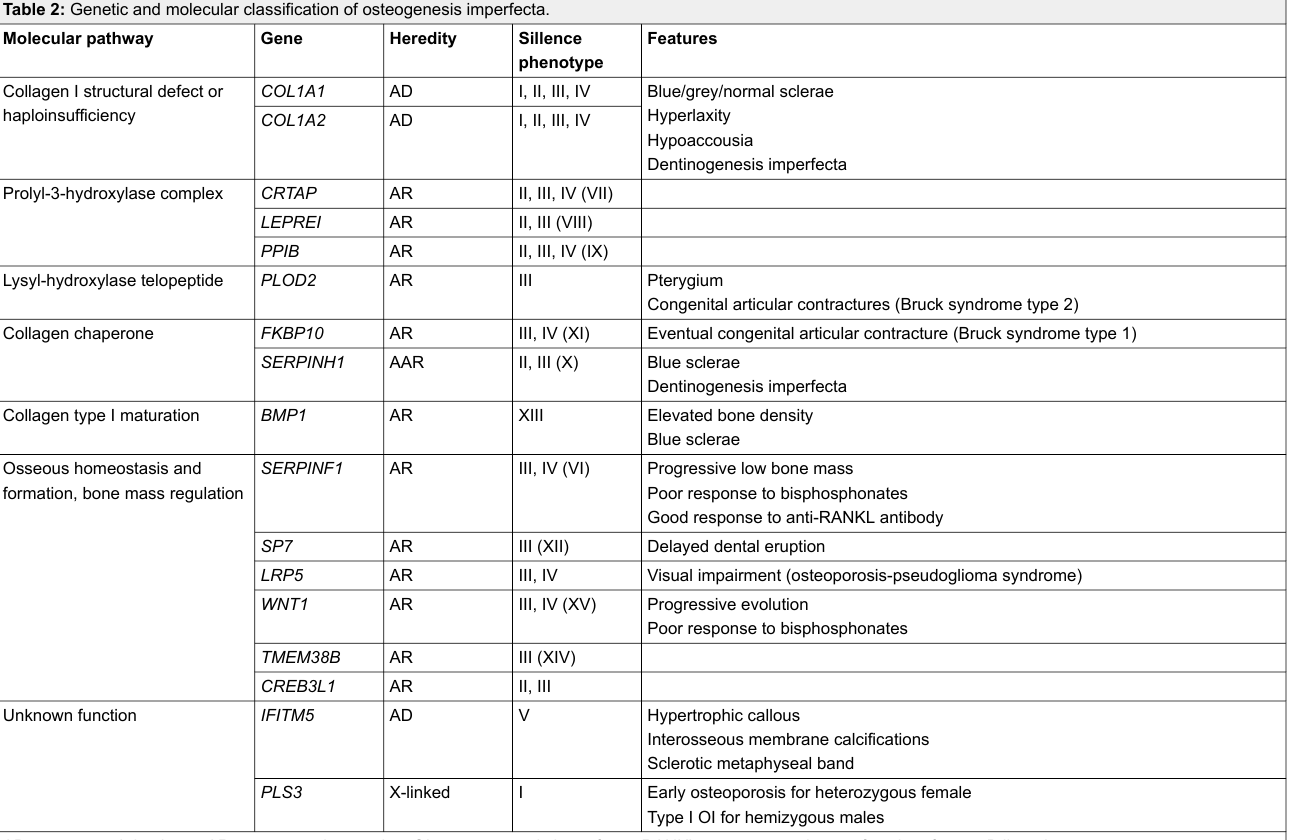
Table 2: Genetic and molecular classification of osteogenesis imperfecta. Molecular